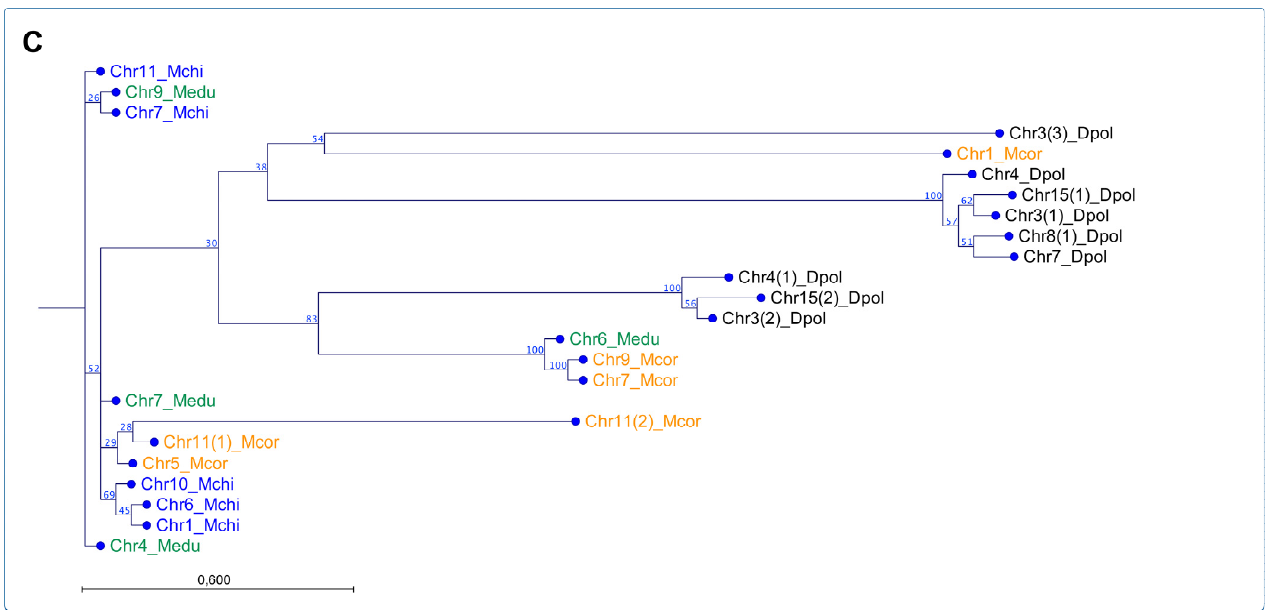
Figure 4. Molecular characterization of Steamer-like elements (SLE) in the M. chilensis genome and phylogenetic analysis using publicly available reference genomes assembled at chromosome level for bivalve species. ( A ) Alignment of five SLE copies localized in chromosomes 1, 6, 7, 10, and 11. All the SLEs are flanked by two LTRs (5 (cid:48) and 3 (cid:48) ) containing the Gag-Pol ORFs and the domains annotated for protease, reverse transcriptase, RNAaseH, and integrase. An insertion composed of 12 nucleotides (933ˆ934 position) was found in chromosomes 7 and 11. The detailed alignment and the translation for the nucleotides inserted are highlighted in the red box. ( B ) Maximum likelihood (ML) phylogenetic tree of nucleotide sequences from SLEs found in eleven reference genomes for Bivalvia. Colored chromosomes and numbers indicate the SLE genome localization and the bivalve species, respectively. The species analyzed were: Veneridae (pink) Ruditapes philippinarum (Rphi) and Mercenaria mercenaria (Mmer); Solenidae (grey) Solen grandis (Sgra); Pectinidae (blue) Pecten maximus (Pmax); Ostreidae (green) Crassostrea gigas (Cgig), C. virginica (Cvir), and C. ariakensis (Caria) ; Pteriidae (light blue) Pinctada imbricata (Pimb); and Mytilidae (red) Mytilus coruscus (Mcor), Mytilus edulis (Medu), and Dreissena polymorpha (Dpol). ( C ) ML analysis of SLEs identified in M. edulis (orange), M. coruscus (orange), D. polymorpha (black), and M. chilensis (blue)